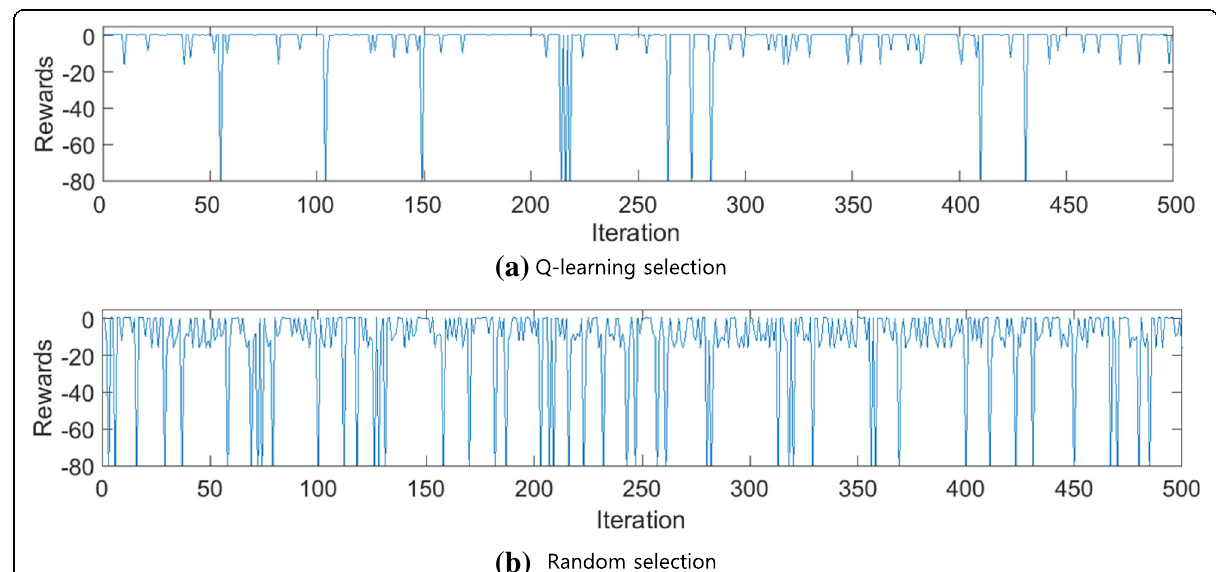
Fig. 23 Rewards for a Q-learning and b random channel selection according to iteration (DDR = 1.5